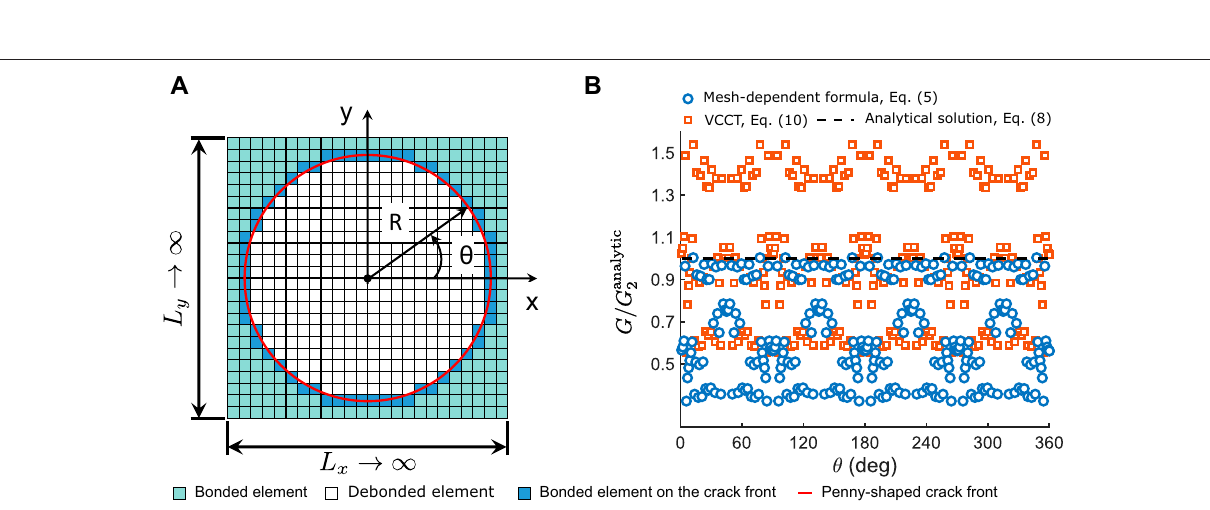
Bonded element on the crack frontBonded element Penny-shaped crack front Debonded element FIGURE4|(A) Schematicofthemeshgridusedinthecrackproblem2,and (B) thedistributionofSERR, G ( θ ),atthecrackfront.Sizeofthecomputationaldomain (cid:1) 2.5 × 2.5 (mm 2 ), tensile normal load P (cid:1) 1 (N), a (cid:1) 1.0 (mm), E * (cid:1) 1 (MPa). The mesh grid is 128 × 128. Penny-shaped crack is located at the center of the computational domain.